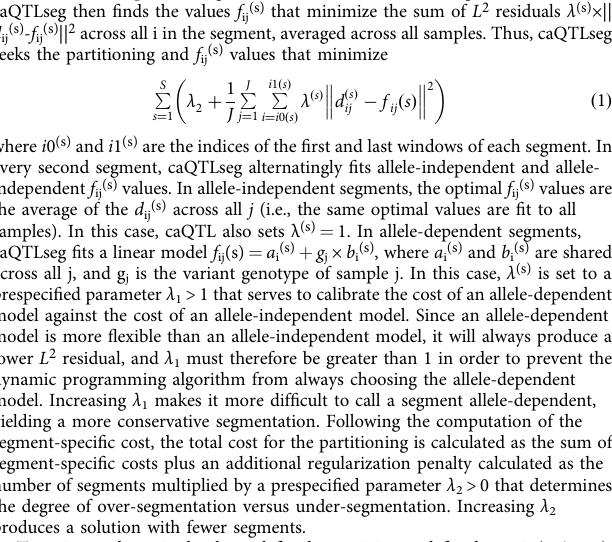
Table 10) with iTaq universal SYBR master mix (cat no. 1725120, Bio-Rad) and GAPDH as endogenous reference genes. To test for association between CRISPR- edited rs4487645 genotype and CDCA7L expression (quanti fi ed as 2 − Δ Ct relative to GADPH ), we used multivariate regression with CDCA7L DNA copy number as a